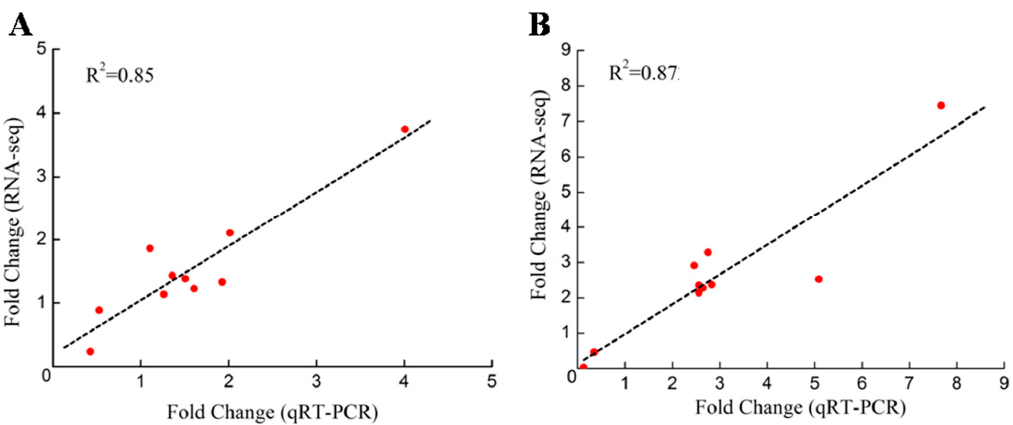
Figure 6. Confirmation of the expression profiles of ten randomly selected unigenes by qRT-PCR. ( A ) A linear regression analysis of the fold-change (6 h vs. 0 h) between the DGE and the qRT-PCR; ( B ) a linear regression analysis of the fold-change (24 h vs. 0 h) between the DGE and the qRT-PCR. Total RNA was extracted from three replicated samples individually for each treatment of shoots and roots ( n = 3).